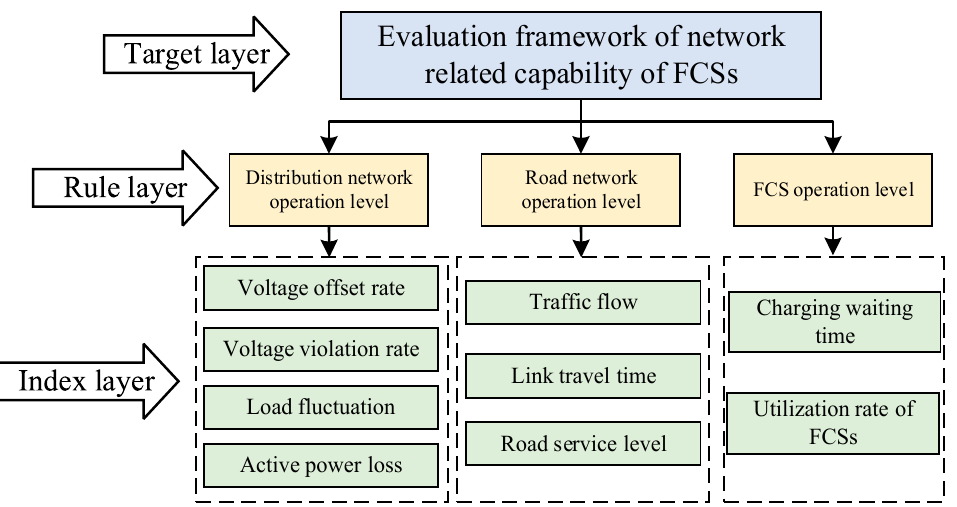
Figure 2. The comprehensive